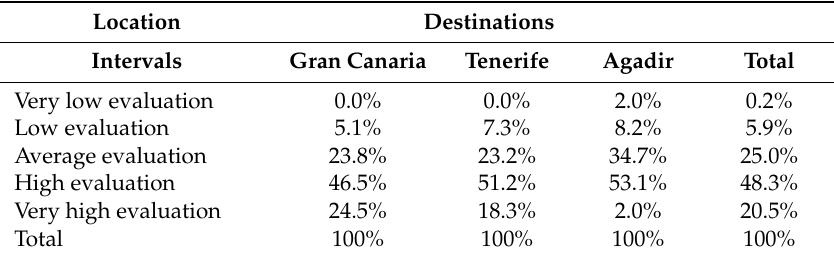
Table 4. Comparative analysis of the location variable.